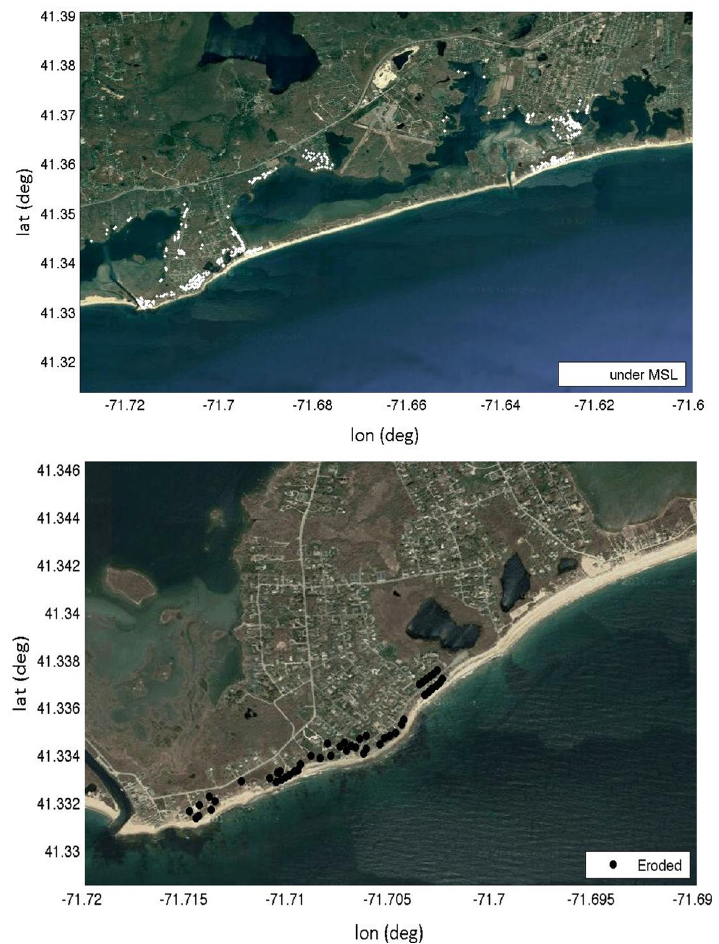
Figure A5. Structure removed because they are lower the MSL with SLR of 2.1 m (7 feet) with dunes eroded (upper panel, white dots). Structures removed because of loss by erosion projected to 2100 using exponential high assumption (lower panel, black dots).